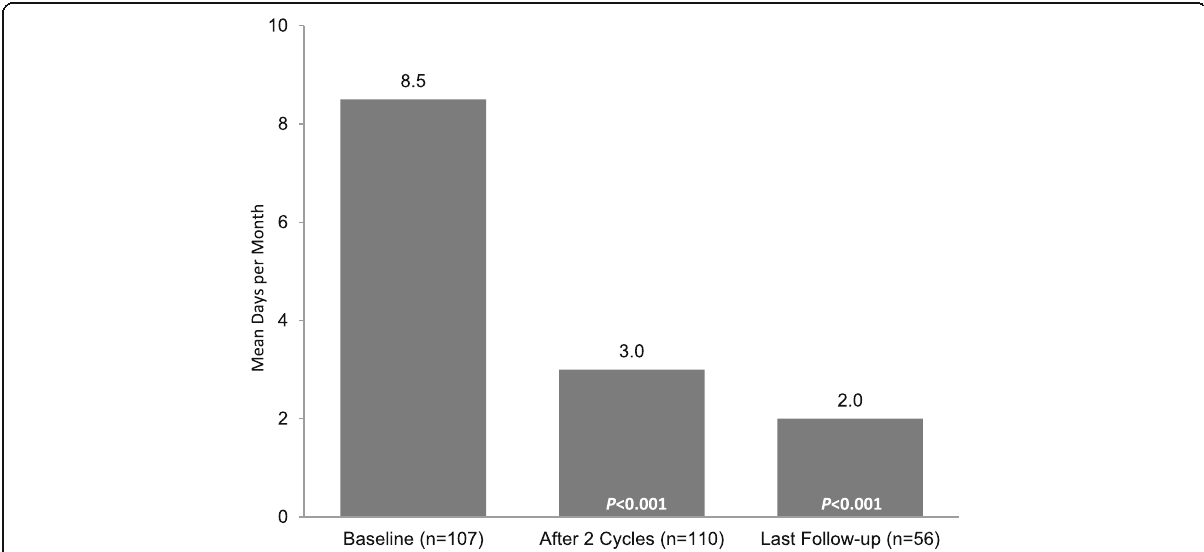
Fig. 4 Work or study days missed due to migraine. P -values indicate significant decrease from baseline, one-sided t